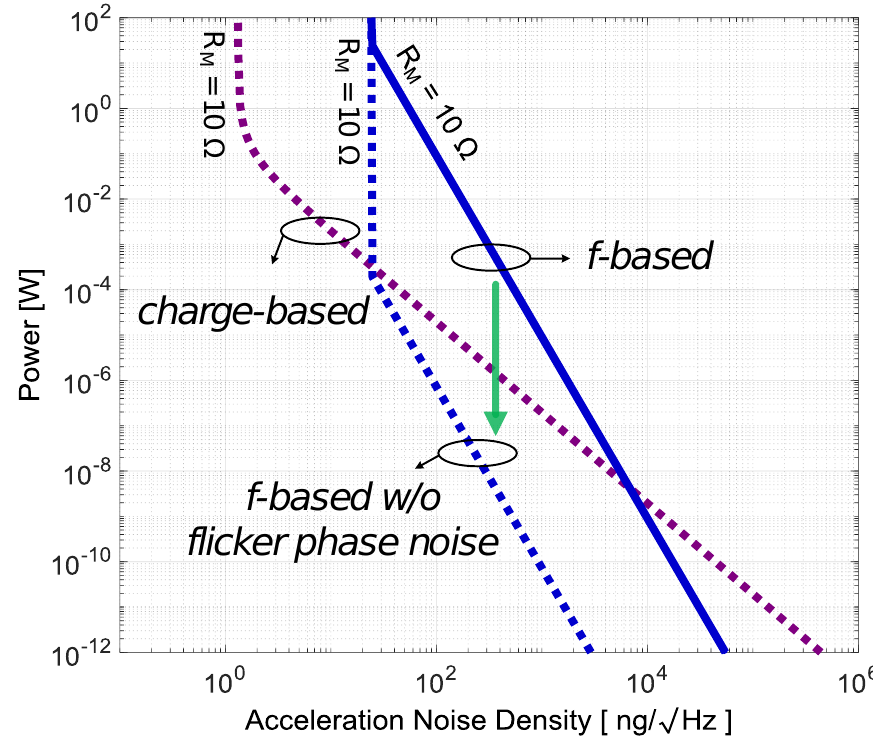
Figure 11. The power-noise curve of frequency-based readout significantly shifts down without flicker phase noise in oscillators. However, there are no techniques to actually accomplish this in real oscillators to